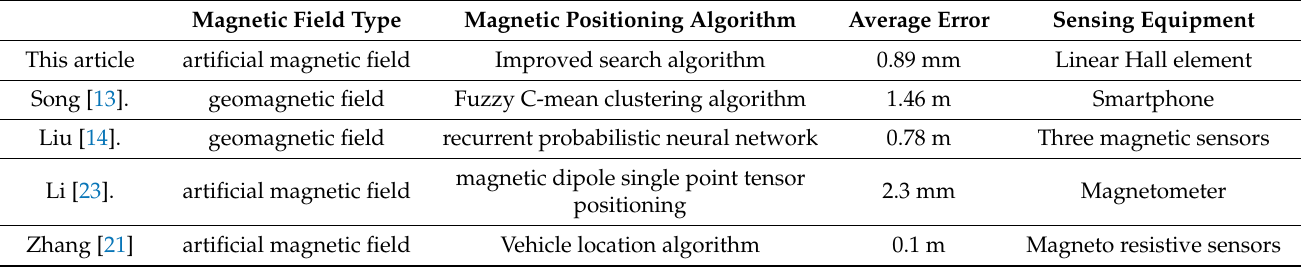
Table 1. The differences among previous research.